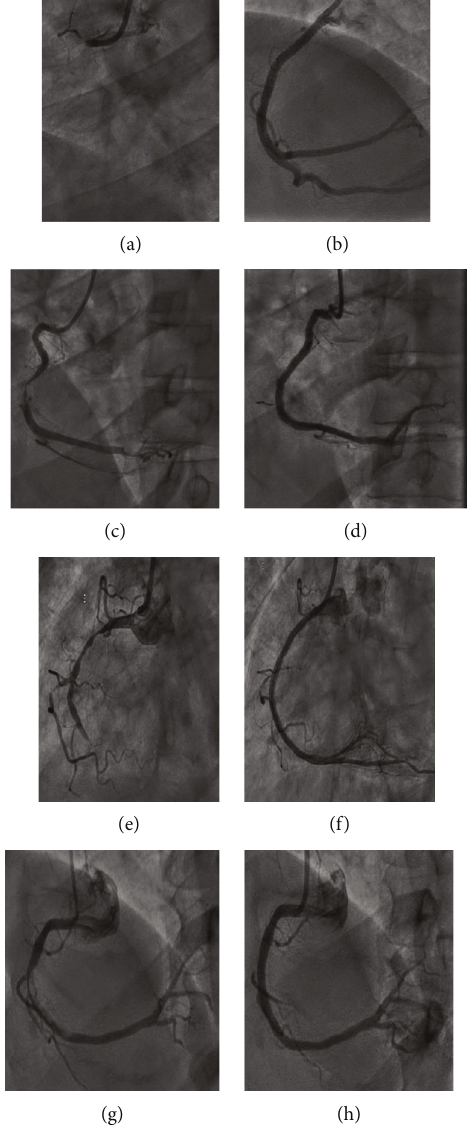
Figure 3: Coronary angiography to the culprit lesion. Case 6: (a) complete thrombotic occlusion in the very proximal segment of right coronary artery (RCA) with TIMI 0 fl ow; (b) successful PCI to proximal to mid-RCA with one drug-eluting stent DES, and TIMI III fl ow was achieved. Case 7: (c) severe thrombotic stenosis in mid-RCA with complete occlusion in the distal part due to distal embolization from the proximal thrombotic lesion; (d) successful thrombus aspiration and PCI to mid-RCA with one DES, and TIMI III fl ow was achieved distally. Case 8: (e) left anterior oblique (LAO) projection for right coronary artery (RCA) showed severe stenosis in the proximal segment followed by thrombotic occlusion from mid to distal RCA segment; (f) successful PCI to the proximal and distal RCA with 2 drug-eluting stent DES, and TIMI III fl ow was achieved. Case 9: (g) severe thrombotic stenosis in mid-RCA segment with TIMI III fl ow, a large thrombus burden in mid-RCA; (h) successful thrombus aspiration and PCI to RCA with 2 overlapping drug- eluting stent DES, and TIMI III fl ow was